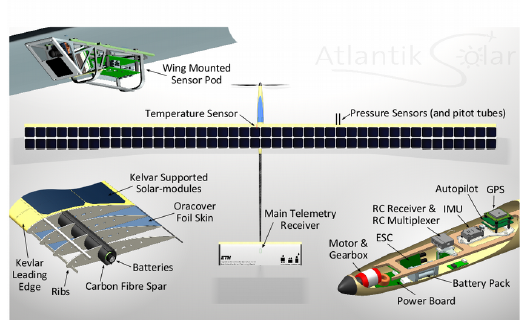
Figure 7. AtlantikSolar main subsystems. Table 1. AtlantikSolar UAS. Technical specifications. Wing span